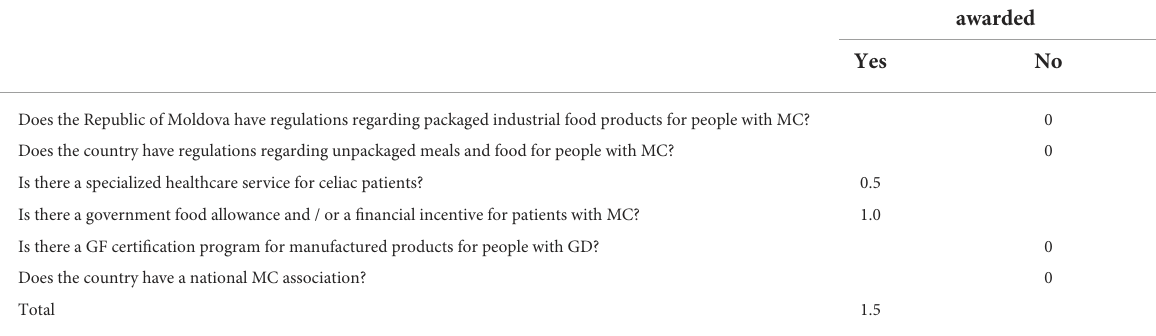
TABLE 1 The public policy score for celiac disease (PPSCD) in the Republic of Moldova. Items used to assess the level of care for people with celiac disease Answer choices and the